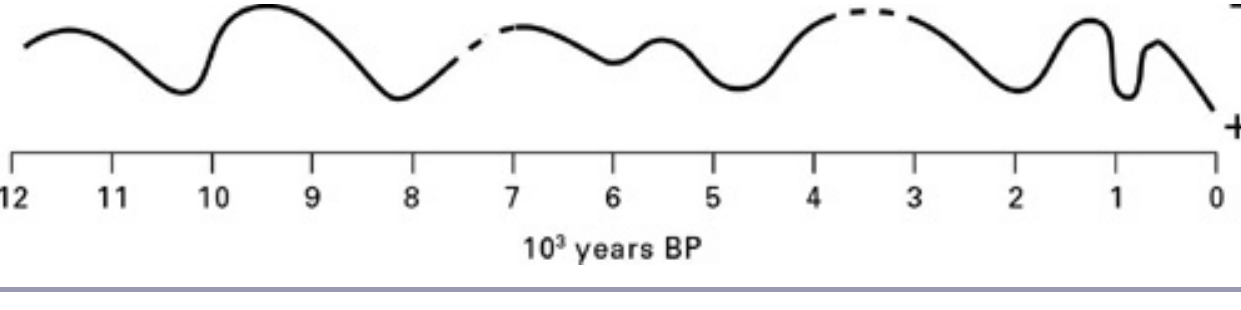
Fig. 6. A restoration trajectory over an arbitrary 24-yr period ( t ) might have been chosen to achieve an 1–24 average balance of target species assemblages ( ___ ). It takes into account the great interannual variability in these species assemblages over time and demonstrates that the evaluation of projects over short time periods will be misleading. Thus, evaluation in year t only would give an impression of a strong bias in 7 favor of some species assemblages, whereas evaluations in years t would give a very different result. 12–14 When externalities such as climate parameters change, the trajectory will take a new direction (----), and restoration expectations and perhaps activities will also have to